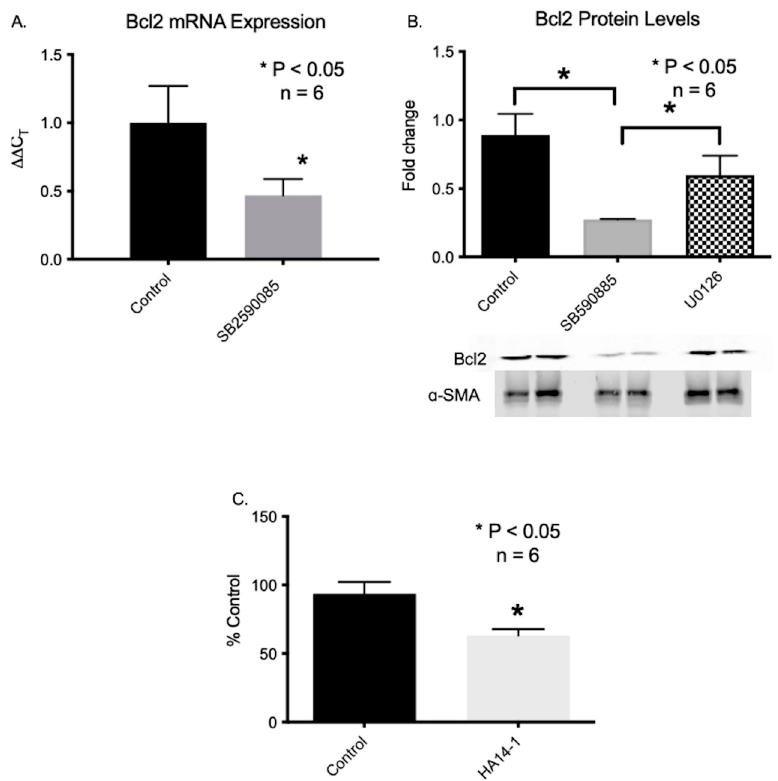
Figure 10. ( A ) The reduction in Bcl2 mRNA following incubation of VSCs with the B-Raf inhibitor. ( B ) The reduction in Bcl2 protein levels in VSCs lysate following incubation with the B-Raf inhibitor. No significant change in Bcl2 protein levels was observed by the incubation of VSCs with the ERK inhibitor. ( C ) The cell death of VSCs following incubation with the Bcl2 inhibitor HA14-1. * Denotes p < 0.05, n = 5.